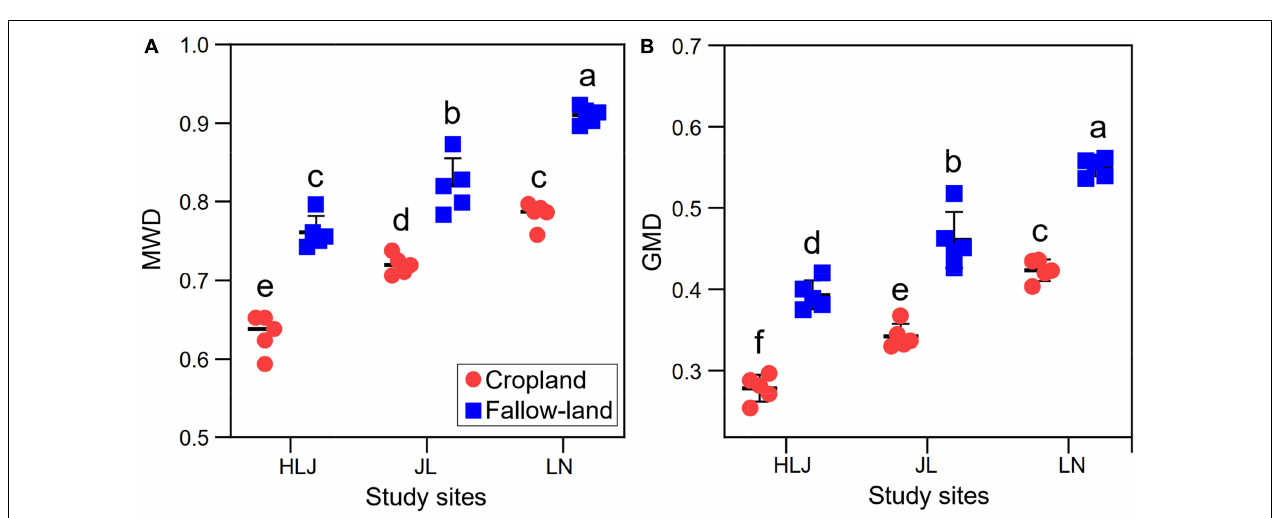
FIGURE 5 | Effects of CC and LUC on MWD (A) and GMD (B) . Different letters indicate significant differences among treatments ( p <